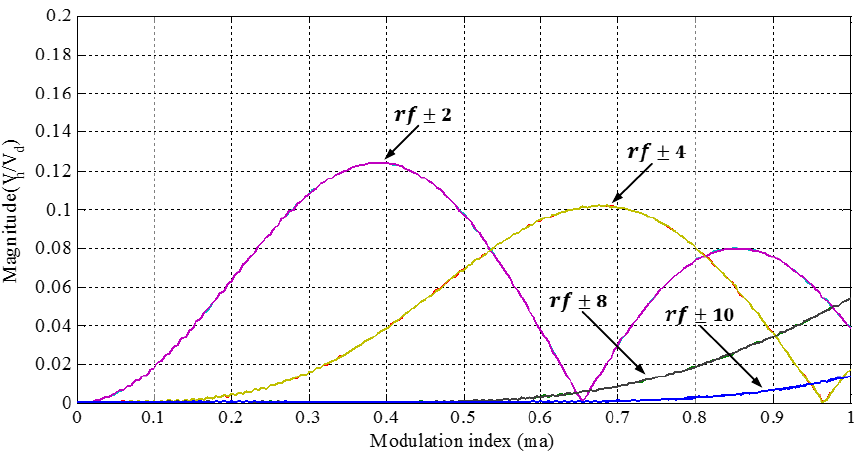
Figure 10. PS-SPWM harmonic distribution according to m a .